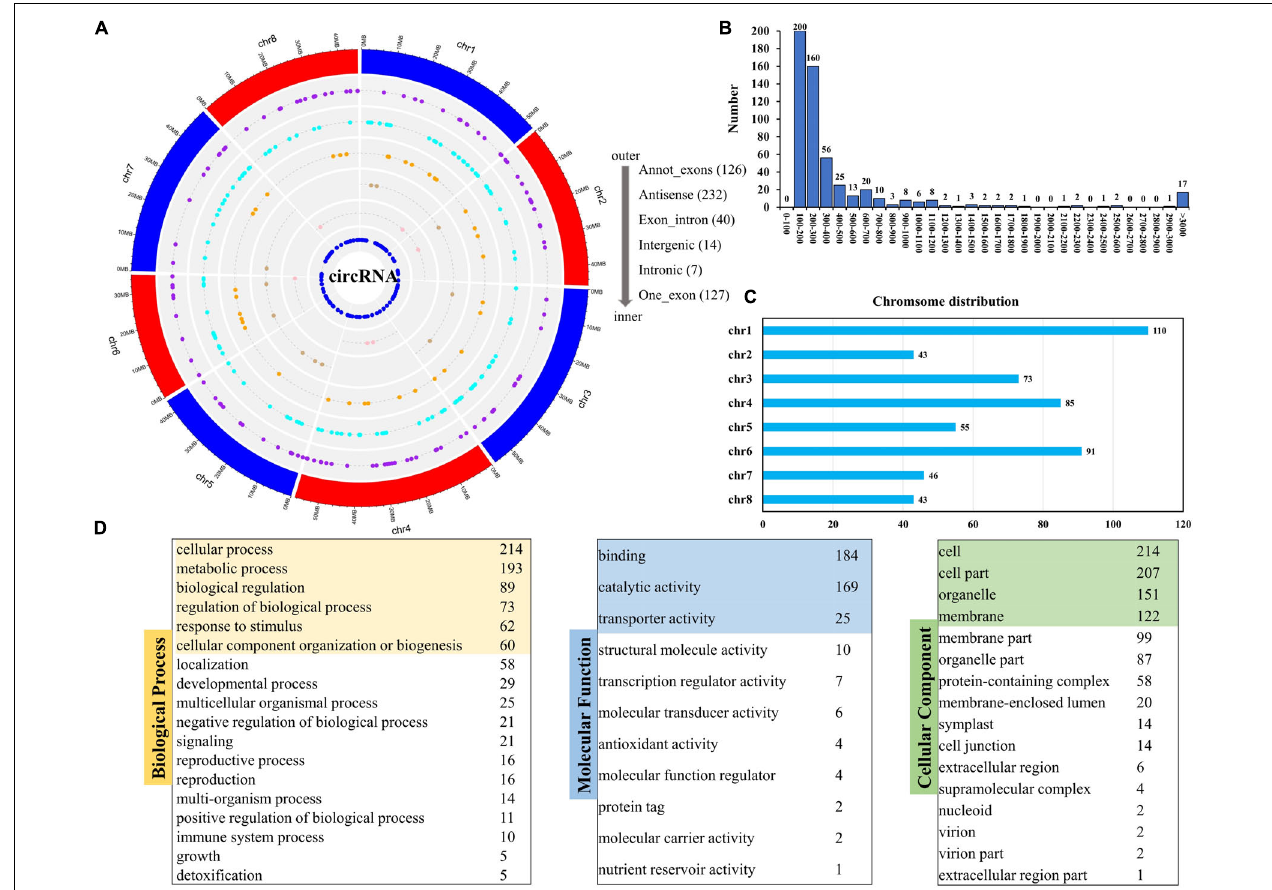
FIGURE 6 | Distribution of circRNAs and GO analysis of source genes. (A) Genomic distribution of different circRNAs types. (B) Number statistics of different circRNAs in length. (C) Chromosome distribution of circRNAs. (D) GO enrichment of all source genes of